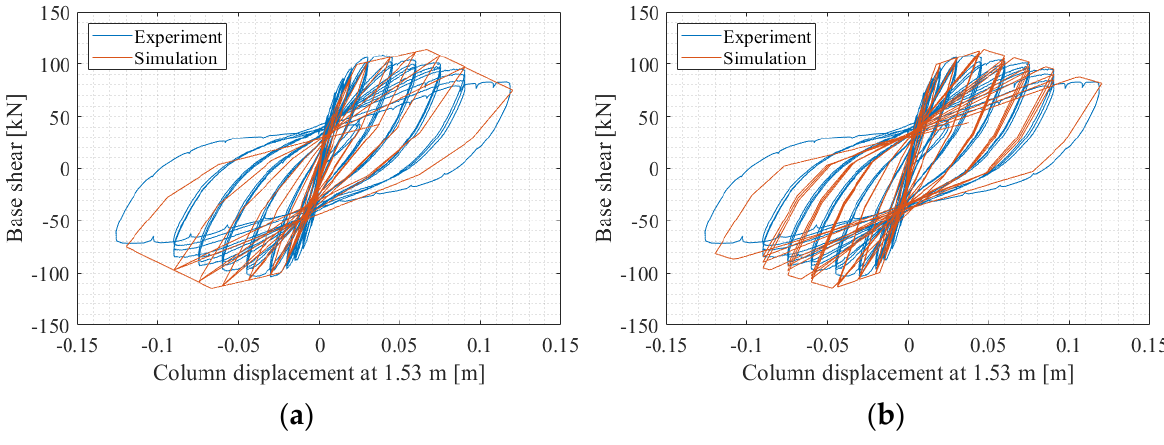
Figure 7. Base shear—displacement at height 1.53 m relationship observed during cyclic test and that obtained from simulation of cyclic response of a column reinforced with DPD2 using ( a ) basic and ( b ) calibrated model.